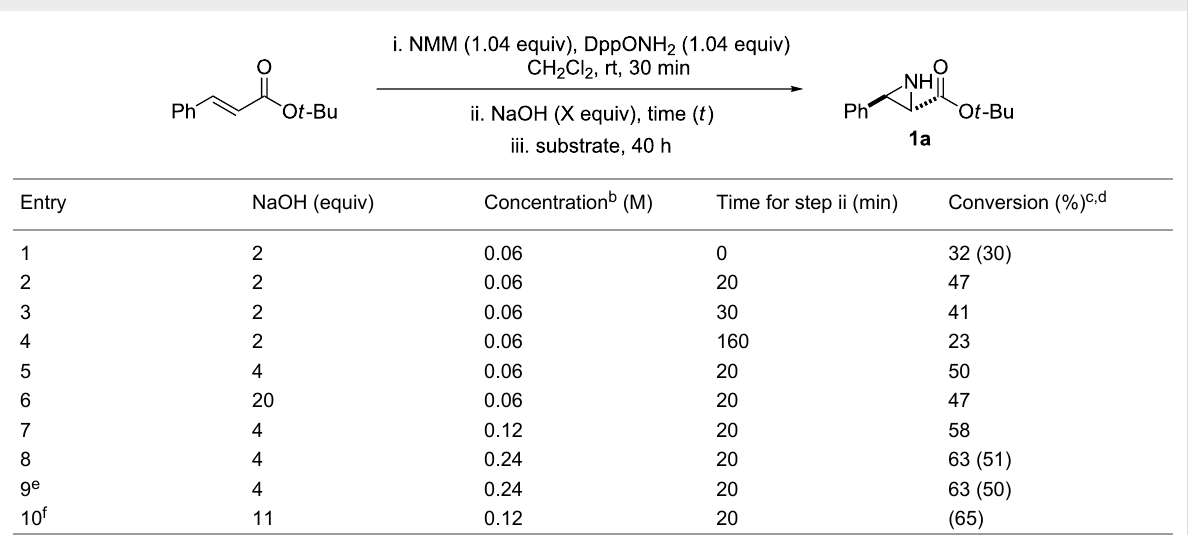
Table 1: Enoate aziridination optimisation.